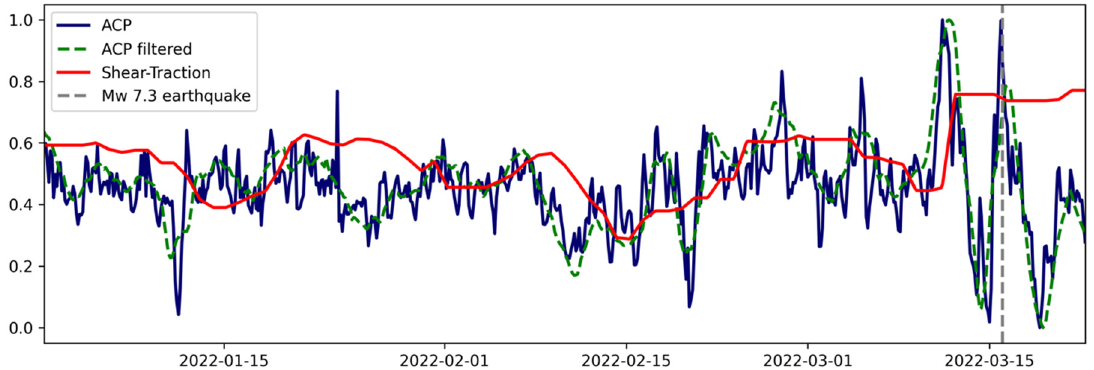
Figure 14. Average of near- and intermediate-field of ACP (unfiltered—blue; filtered—green) and shear-traction field (red) in the epicentral area of the 16 March 2022 Fukushima earthquake, Japan (time shown with grey vertical dashed line). The ACP follows the temporal evolution of the shear- traction field before the earthquake, while the spike in ACP occurs at the same time and shear- traction increases.